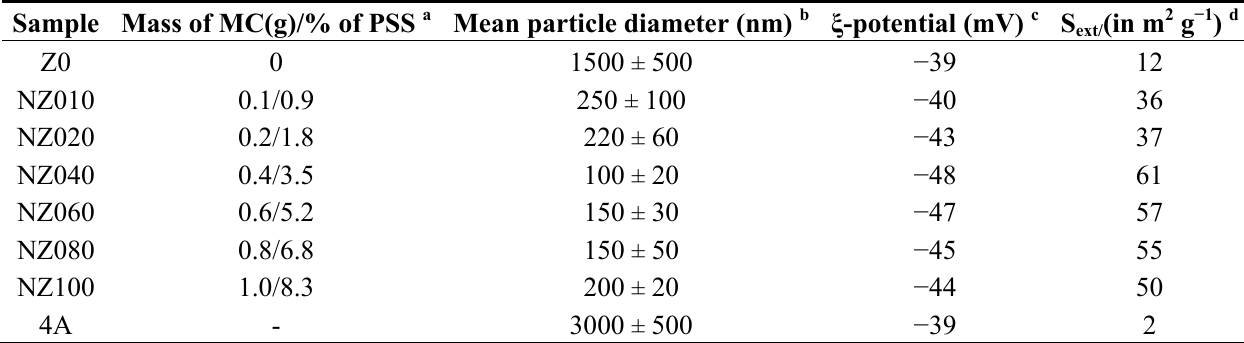
Table 1. Experimental conditions for the synthesis of nanosized zeolite A particles and the corresponding